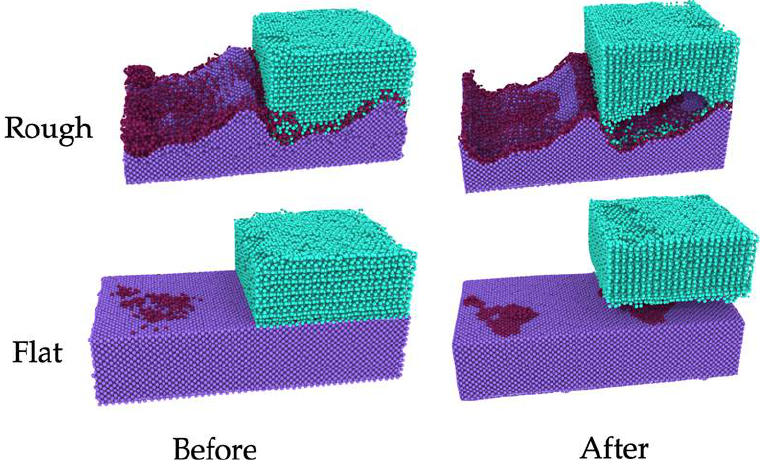
Figure 3. Interfacial quasi-liquid water on flat and rough surfaces before and after ice detachment. Each of the four snapshots are a two-times copy of the periodic simulation box where the left copy has the ice removed for visualisation purposes. The water molecules in the quasi-liquid layer are colored in dark red, while the ice is coloured cyan. All the snapshots are taken from surfaces with an epsilon value of 0.05 eV. All the figures, including detemining water and ice molecules, were made by the visualization software Ovito [62].